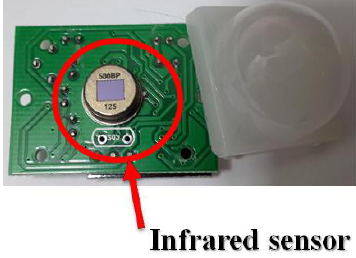
Figure 21. Main infrared sensor